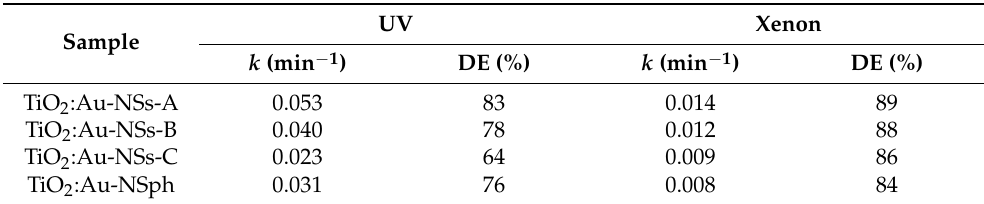
Table 1. CIP degradation efficiencies (DE, %) and corresponding apparent reaction rate constants ( k ) under 30 min of UV radiation and 150 min of visible radiation for TiO 2 :Au-NSs-A, B, and C nanoparticles. Sample